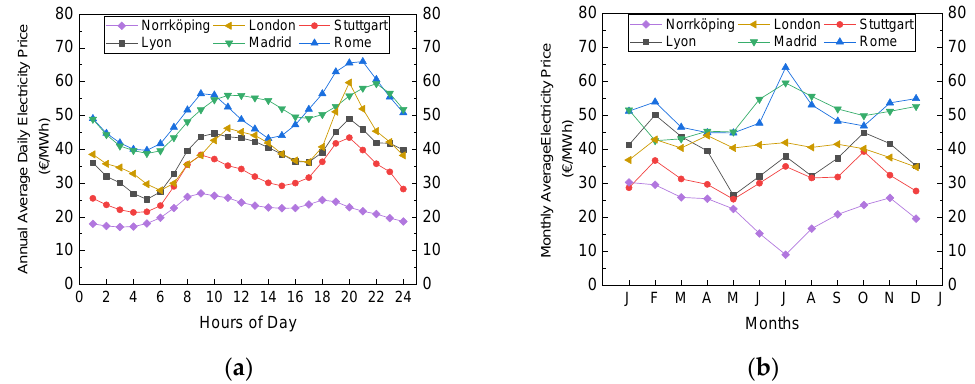
Figure 6. Annual daily and monthly average spot market prices for the year 2015 from the various climatic locations. ( a ) Annual daily average and ( b ) Monthly average spot market prices.